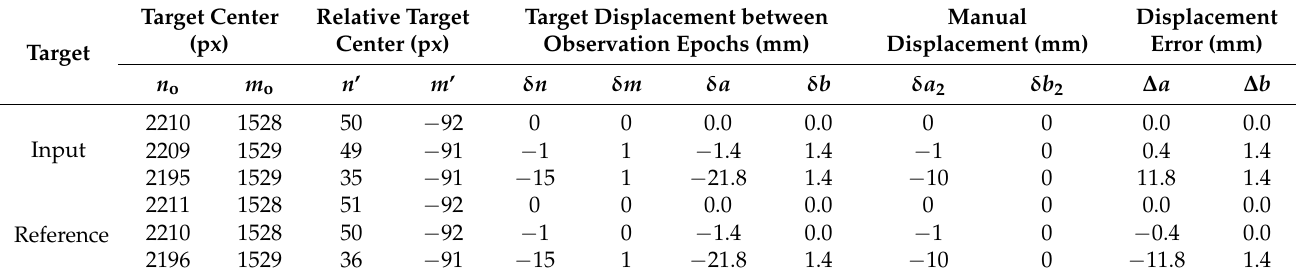
Table 5. Displacement determination for QR target at distance S = 25 m.